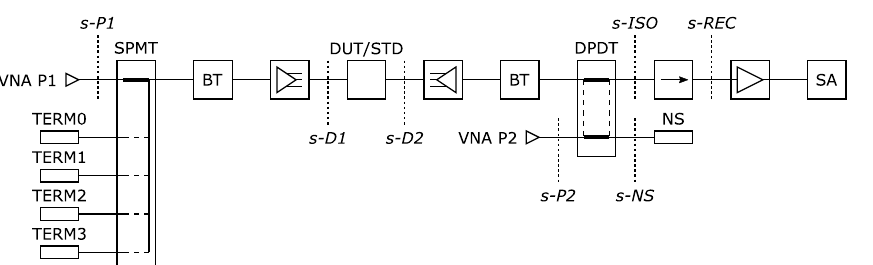
Figure 2. Block diagram of the cold-source noise test bench. From the left to the right along the noise measurement chain: cold (variable) terminations, SPMT switch, input bias-T, input RF probe, DUT or TRL standard, output RF probe, output bias-T, DPDT switch, ferrite isolator, pre-amplifier, spectrum analyzer. In addition, the SPMT is connected to the VNA’s port 1 while the DPDT switch is in connected to a solid-state noise source and to the VNA’s port 2. The SPMT switch is actually realized by combining a SP4T switch and a DPDT